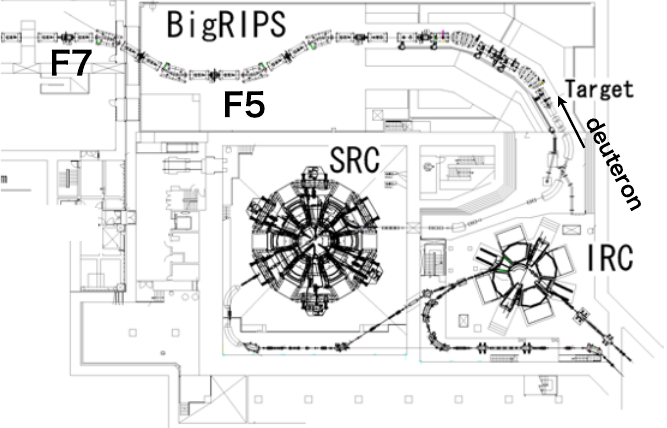
Fig. 1. A schematic view of the experimental site, RIBF [9]. The T d = 250 MeV / nucleon deuteron beam is accelerated by the cyclotron SRC and impinges on the target. The 3 He particles are momentum analyzed and measured at the dispersive focal plane F5. The F5-F7 section is used for particle identification purposes.